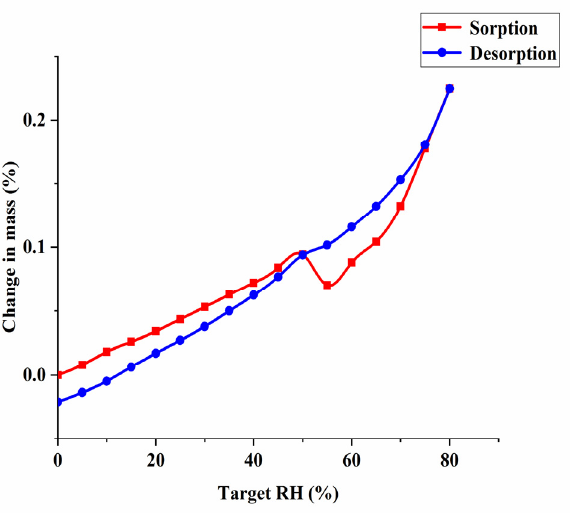
Figure 11 . DVS isotherm plot for the multicomponent crystal of Met–Bar. Figure 11. DVS isotherm plot for the multicomponent crystal of